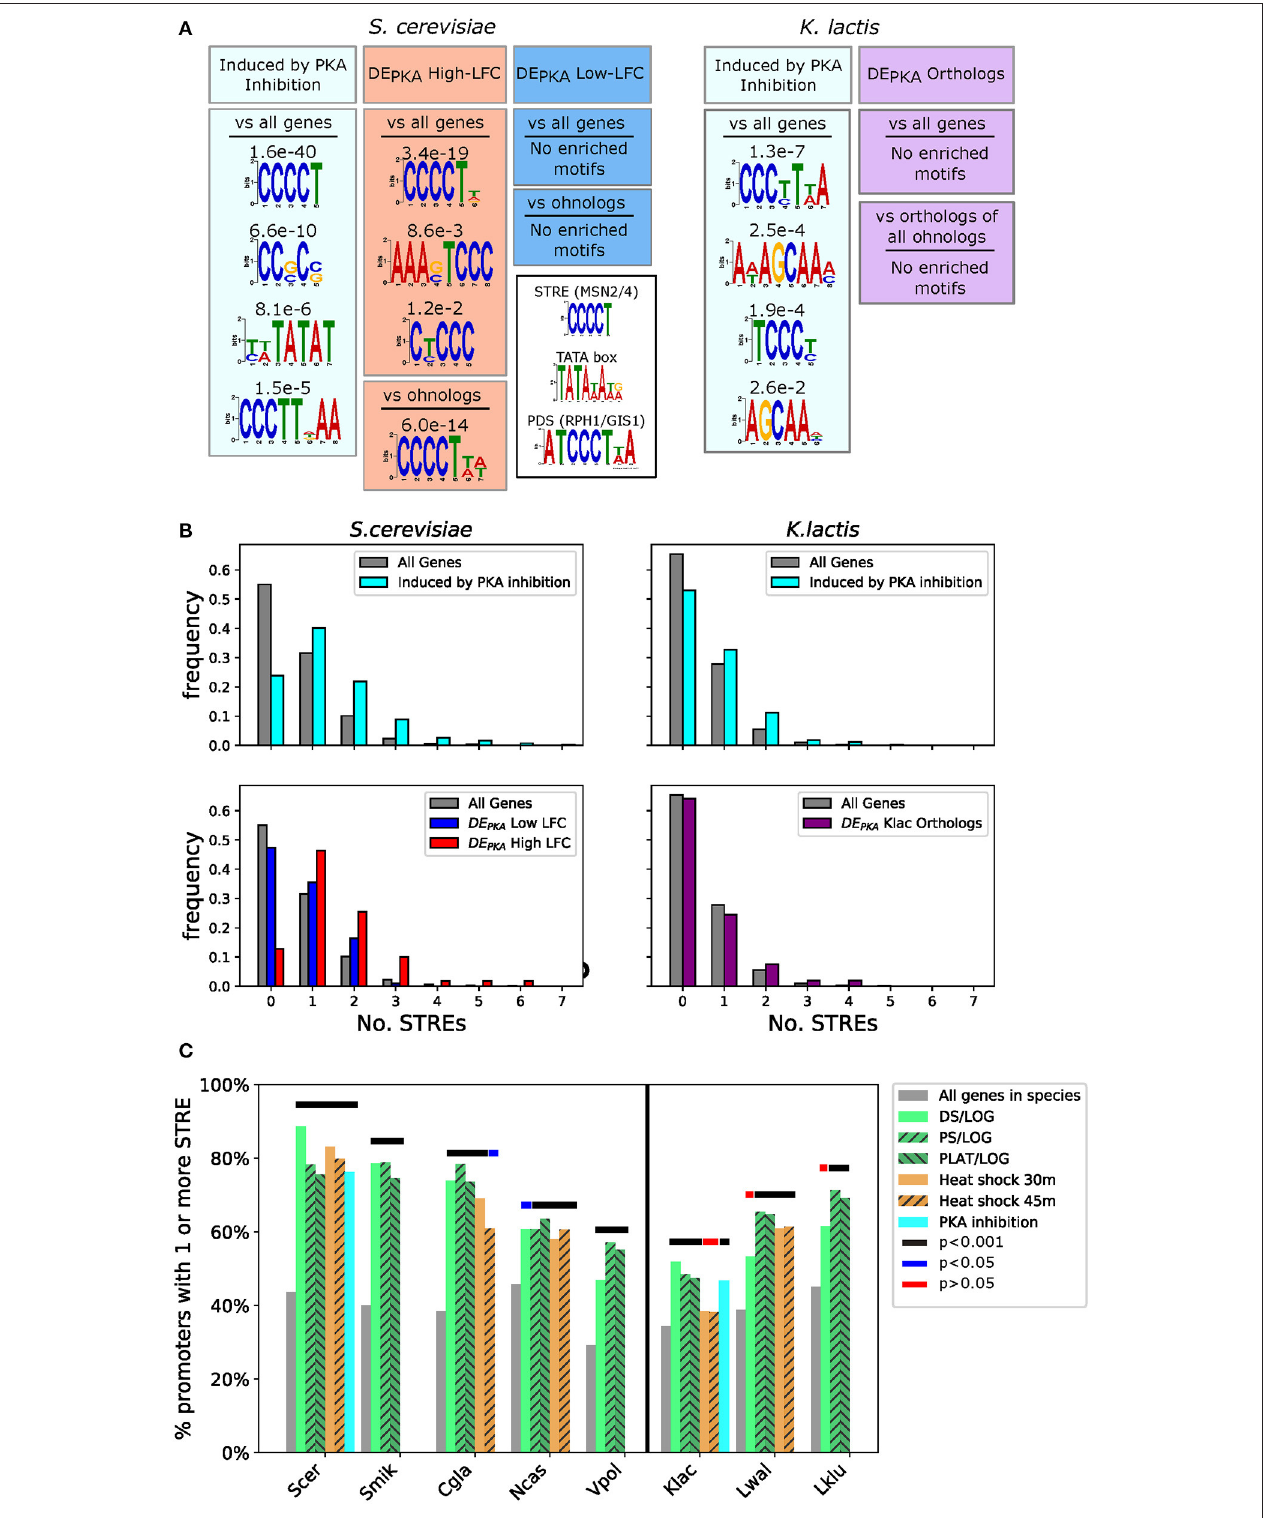
FIGURE 4 | The STRE is enriched in the promoters of DE PKA high-LFC ohnologs, as well as in the promoters of genes induced by PKA inhibition and PKA-related stress in various species. (A) Motifs identified (if any with E < 0.05) using the DREME algorithm from the MEME suite (Bailey, 2011) as enriched in the promoters of